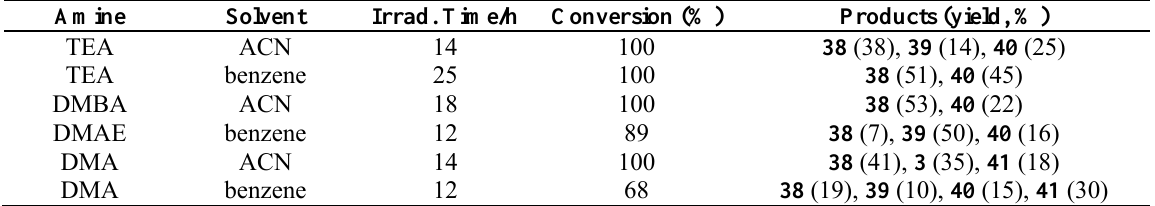
Table 4. Photoinduced reactions of flavone with